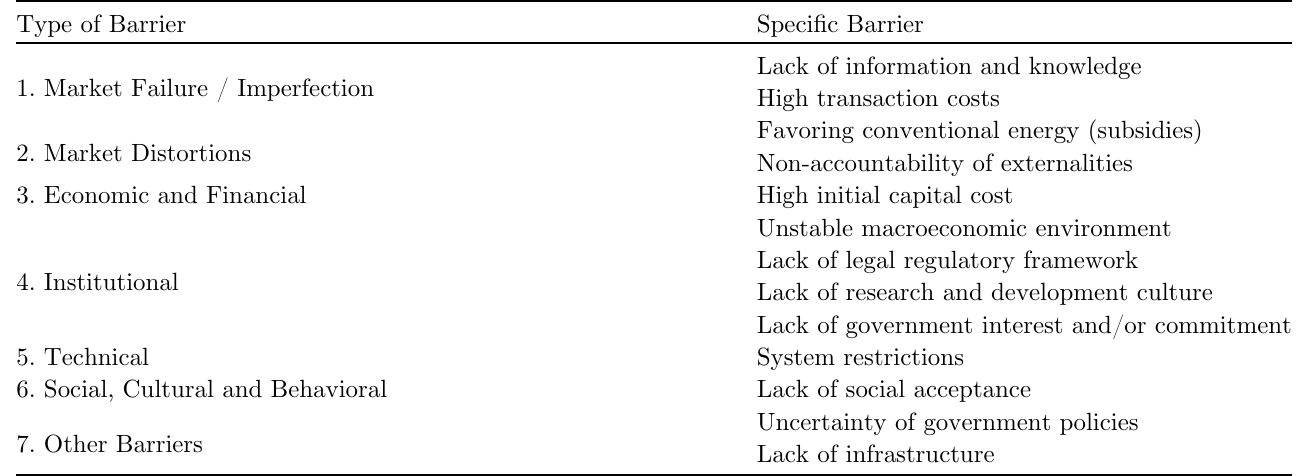
Table 5. Summary of the Main Barriers to the Expansion of Wind Energy in Brazil. Type of